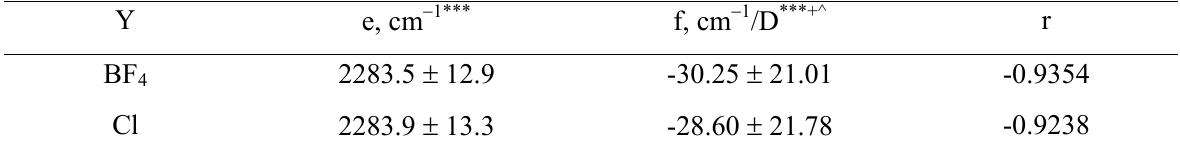
Table 4b. Correlations of stretching vibrational frequencies ( ν ) for fragment C-N + ≡ N bonds in